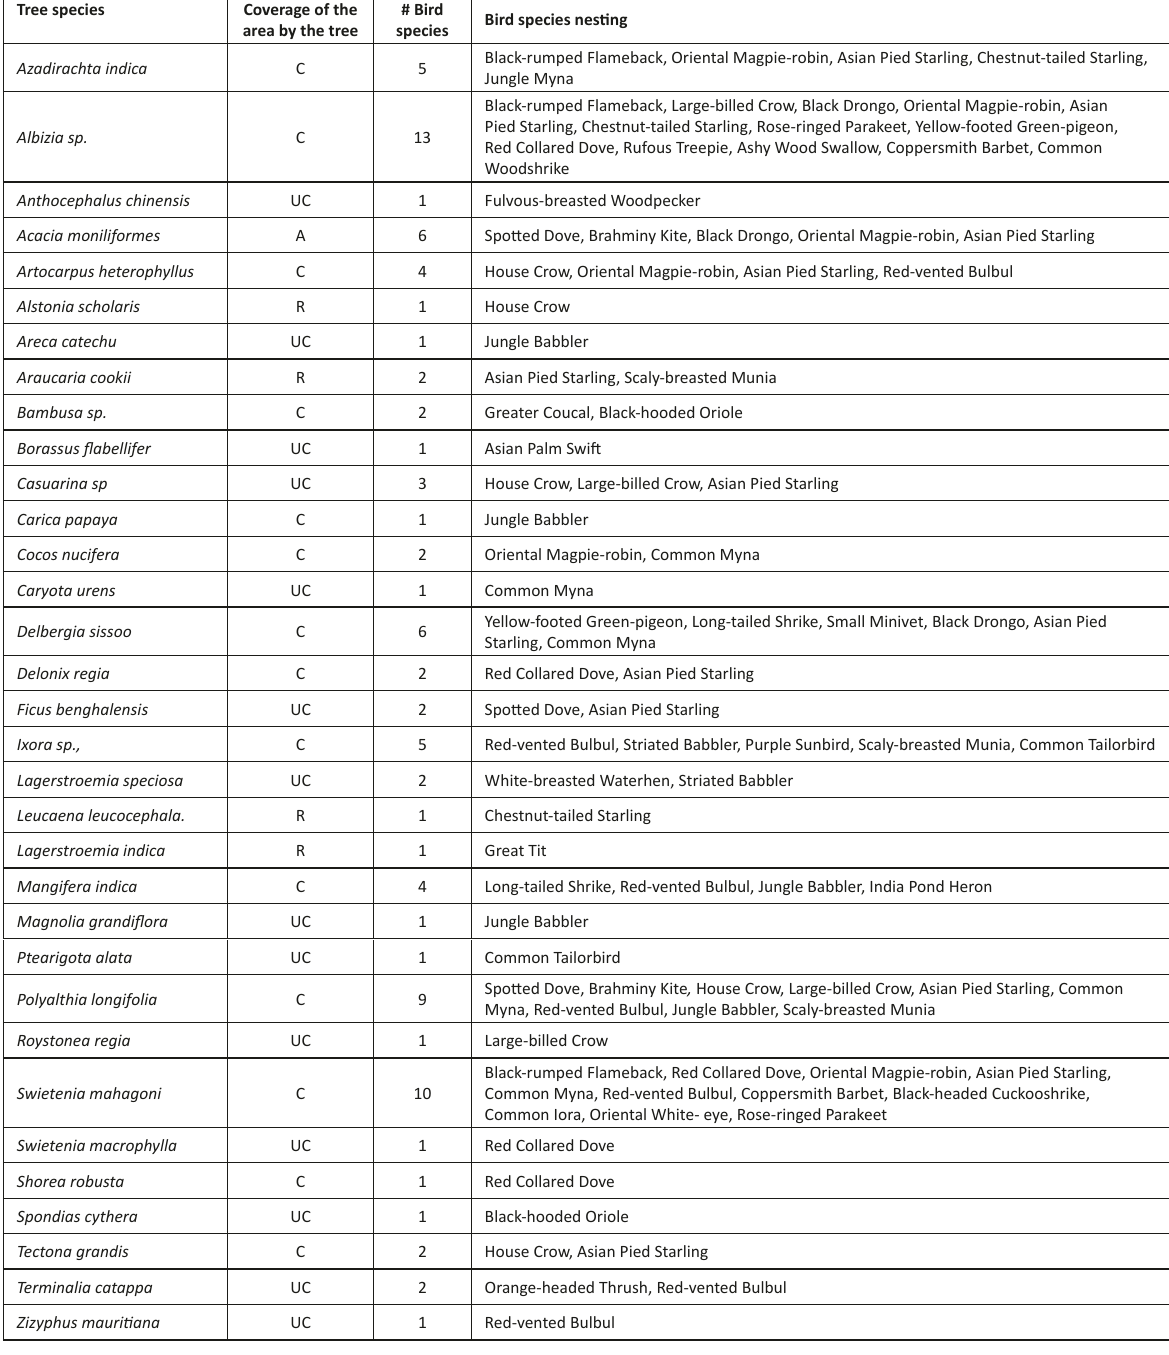
Table 2. Tree species used for nesting by different bird species trees Tree species Coverage of the